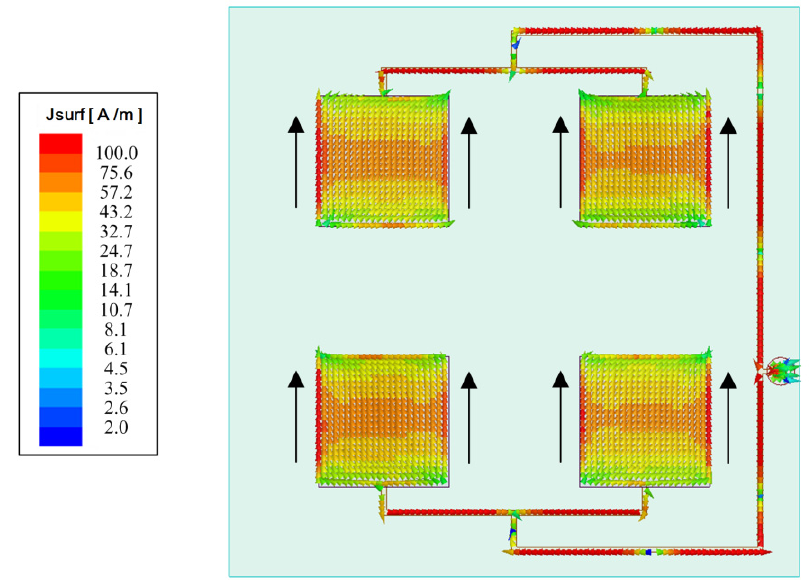
Figure 9. Currents distribution on the patch array at 5.8 GHz.